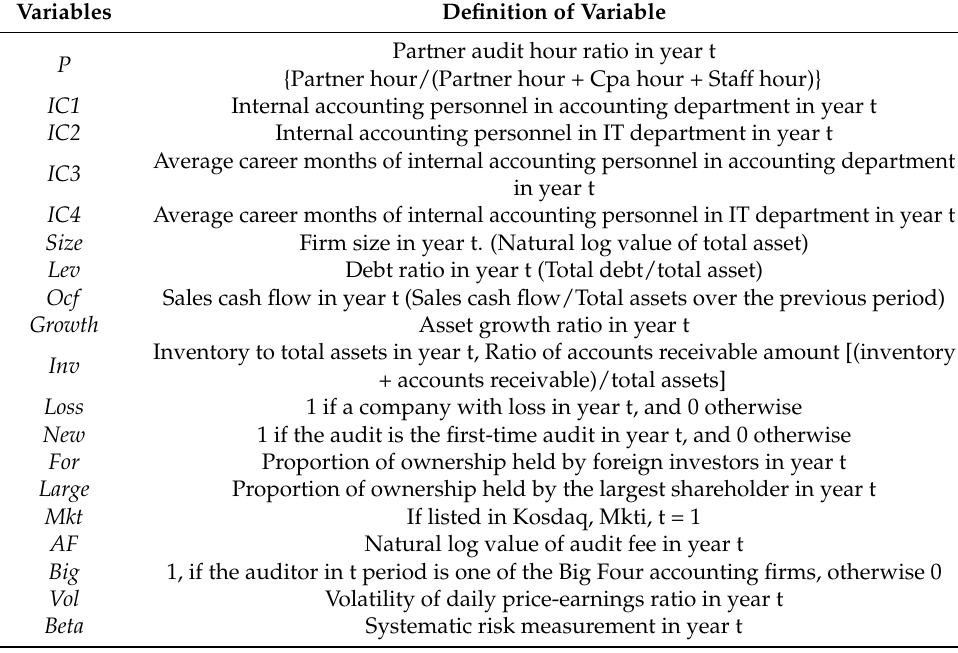
Table 3. Definition of